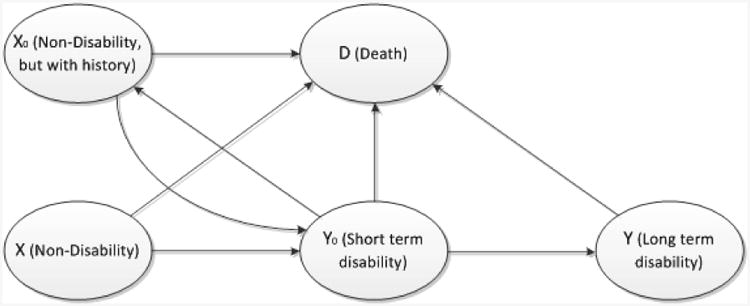
The Markov model for disease progression for a specific sex/diabetes status cohort